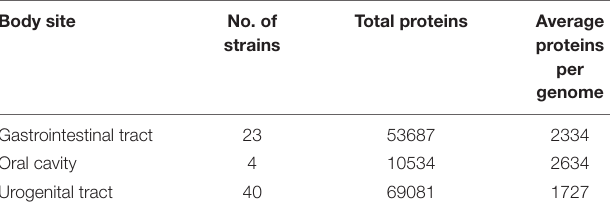
TABLE 1 | Summary dataset of Lactobacillus strains used for comparative